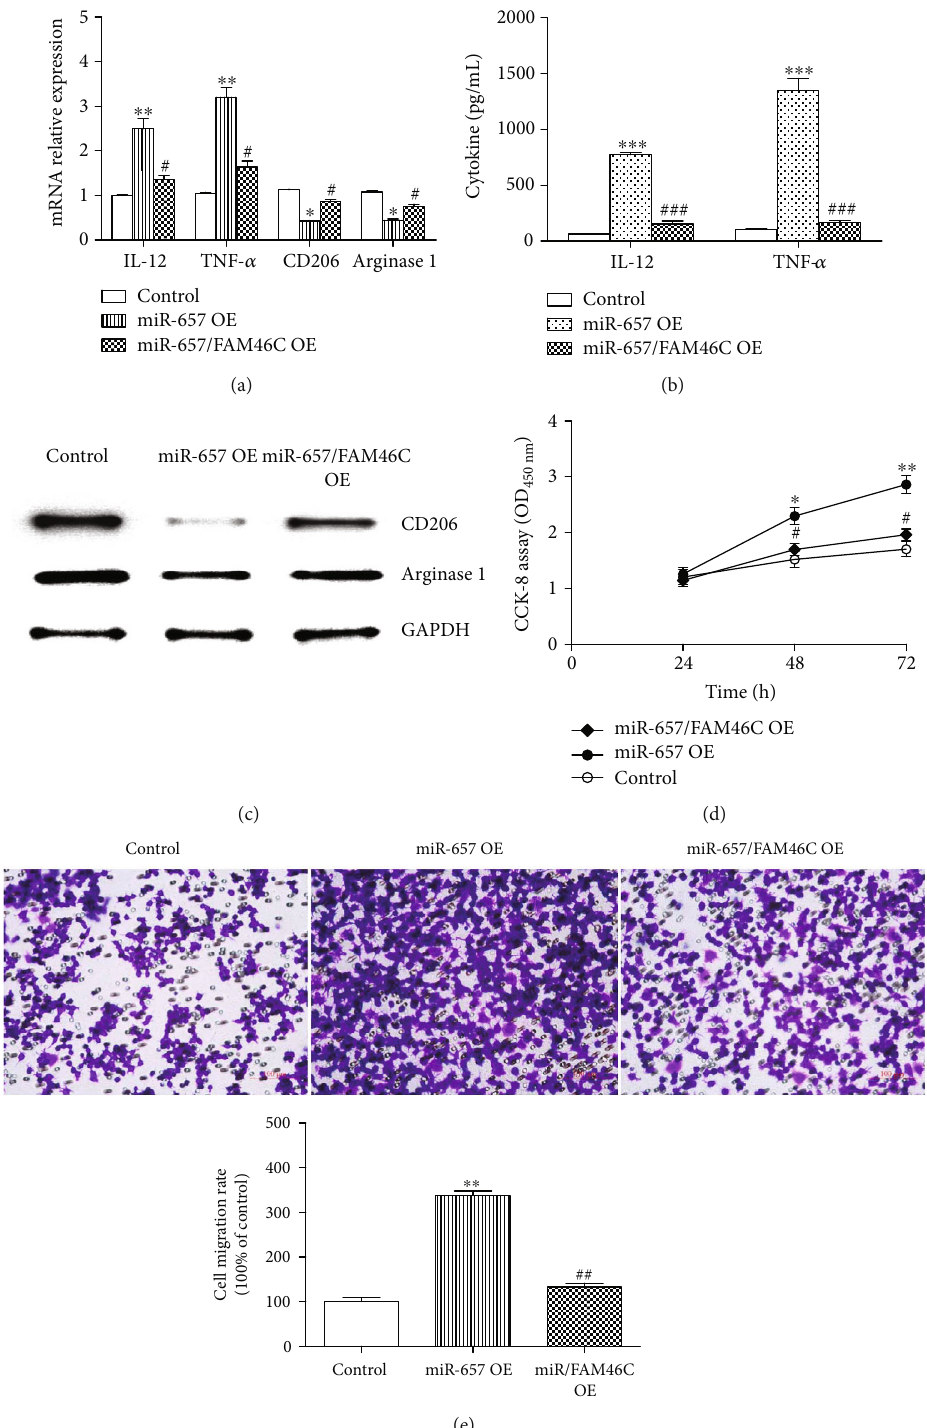
Figure 5: miR-657 promotes macrophage polarization toward M1 via FAM46C. (a) mRNA expression of IL-12, TNF- α , Arginase 1, and CD206 in miR-657/FAM46C overexpressed THP-1 macrophages (compared with the control group, ∗ P < 0 : 05 , ∗∗ P < 0 : 01 ; compared with the miR-657 overexpressed (OE) group, # P < 0 : 05 ; n = 3 ). (b) Expression of IL-12 and TNF- α in the cultural supernatant of THP-1 cells (compared with the control group, ∗∗∗ P < 0 : 001 ; compared with the miR-657 OE group, ### P < 0 : 001 ; n = 3 ). (c) Western blot estimating the protein expression of Arginase 1 and CD206 in macrophages (representative picture of three repeated tests). (d) The proliferation status of miR-657/FAM46C overexpressed macrophages (compared with the control group, ∗ P < 0 : 05 , ∗∗ P < 0 : 01 ; compared with the miR-657 OE group, # P < 0 : 05 ; n = 3 ). (e) Transwell assay estimating the migration of miR-657/FAM46C overexpressed THP-1 cells (compared with the control group, ∗∗ P < 0 : 01 ; compared with the miR-657 OE group, ## P < 0 : 01 ; n = 3